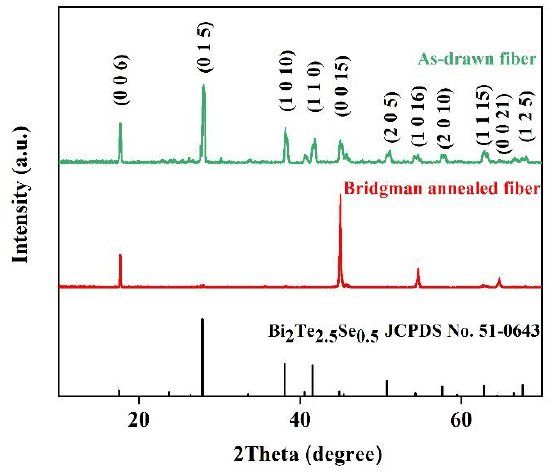
Figure 2. XRD patterns of the as-drawn and Bridgman annealed n-type Bi 2 Te 3 -based fiber.